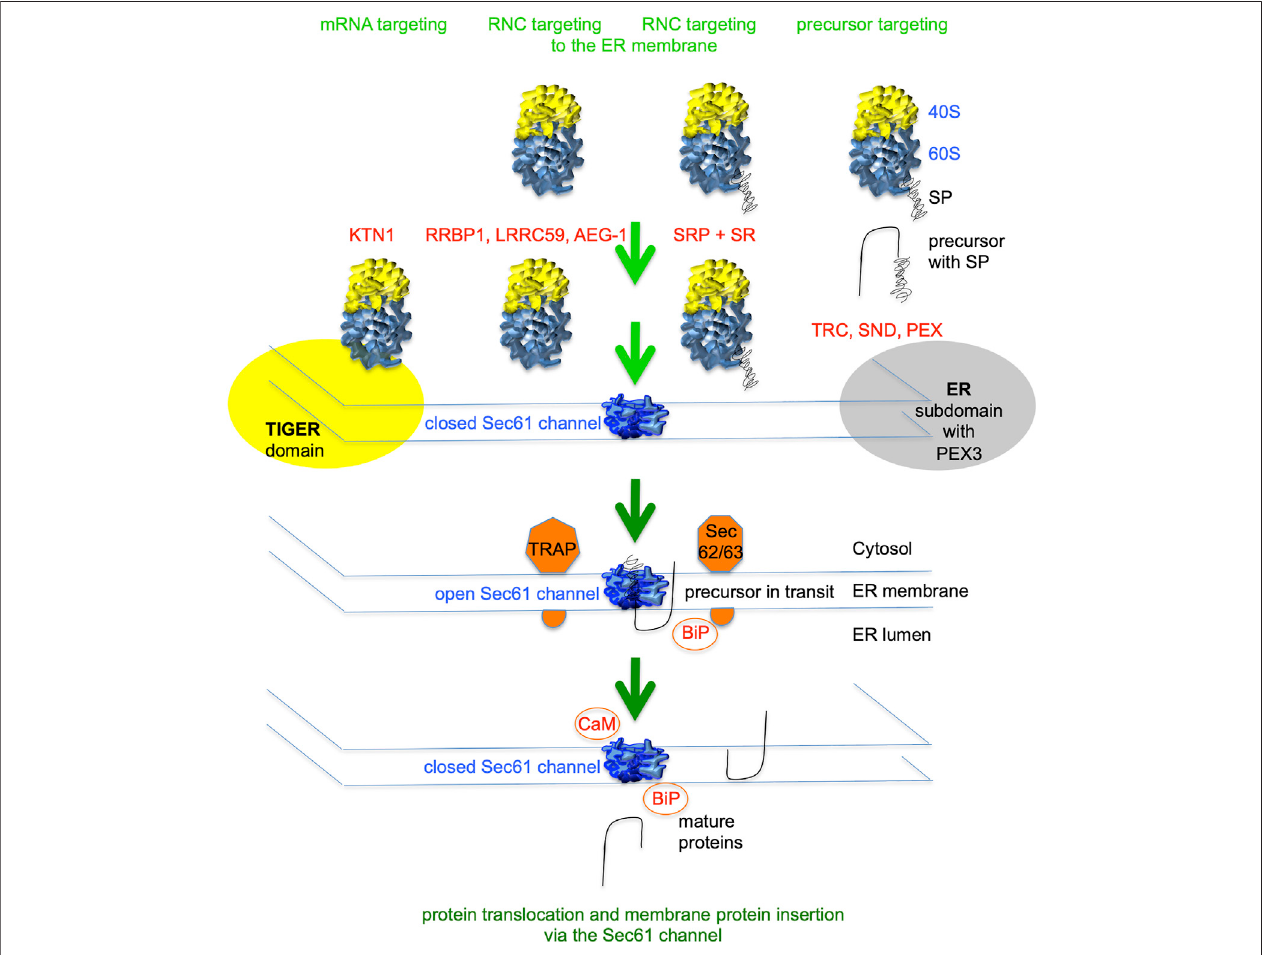
FIGURE2| Flowdiagramforsignalpeptide-dependent importofprecursorpolypeptidesintothehumanendoplasmicreticulum(ER).ERimport ofmostprecursor polypeptides involves the Sec61 channel in the ER membrane, which mediates membrane insertion of membrane proteins and translocation of soluble proteins with N-terminalsignalpeptides (SPs).Typically,SPsofnascentprecursorpolypeptidesarecotranslationallytargeted totheSec61complexintheERmembrane bySRPand its dimeric receptor in the ER membrane (SR). Others are targeted co- or posttranslationally by the TRC-, PEX19/PEX3- or hSnd2/hSnd3-pathway. Furthermore, therearecomponentsformRNA-and/orRNC-targetinglocatedintheERmembrane.AdditionalERmembraneproteinssupportSec61channelgatingtotheopenstate (TRAPorSec62/Sec63)ormembraneproteininsertion,suchasEMC(notshown).ChannelgatingtotheclosedstatecanbesupportedbycytosolicCa 2+ -CaMorBiPin the ER lumen (Erdmann et al., 2011; Schäuble et al., 2012). The green arrows symbolize progress of the import reaction. See Table 1 for a complete list of proteins that are involved in ER protein import.